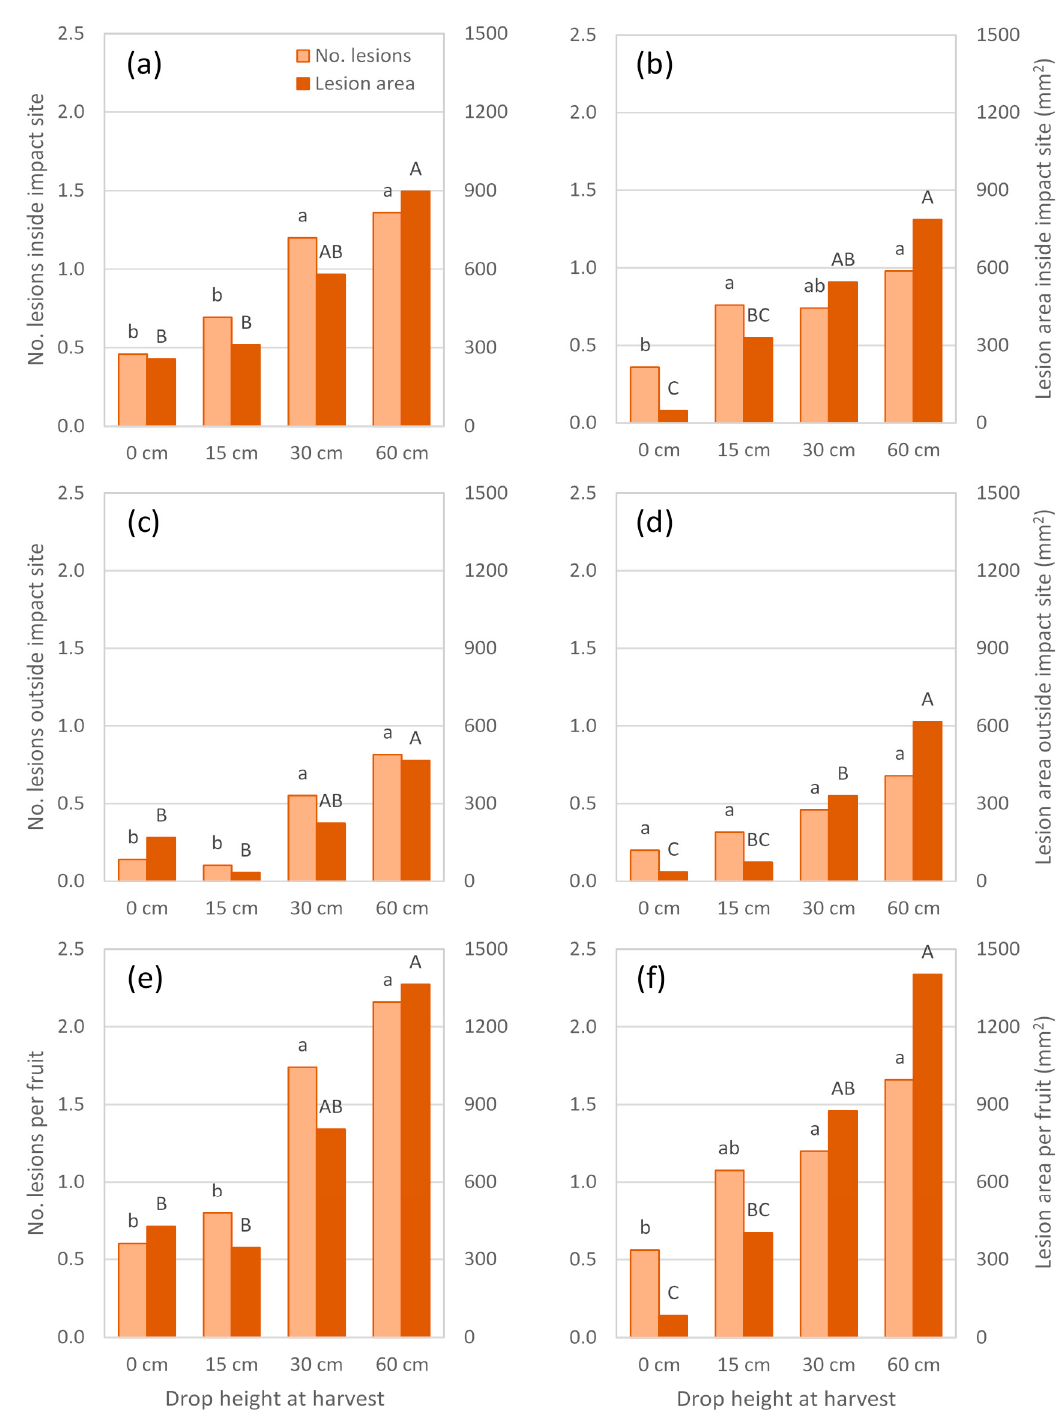
Figure 5. Lesion number and lesion area inside the impact site ( a , b ), outside the impact site ( c , d ) and for the whole fruit ( e , f ) in 2017 season ‘Hass’ avocado fruit dropped 0, 15, 30 or 60 cm on the day of harvest in Experiment 4 ( a , c , e ) and Experiment 5 ( b , d , f ) and assessed at soft-ripe stage. Means that do not share a letter (lowercase for lesion number, uppercase for lesion area) are significantly different ( p < 0.05) according to Fisher’s LSD test.